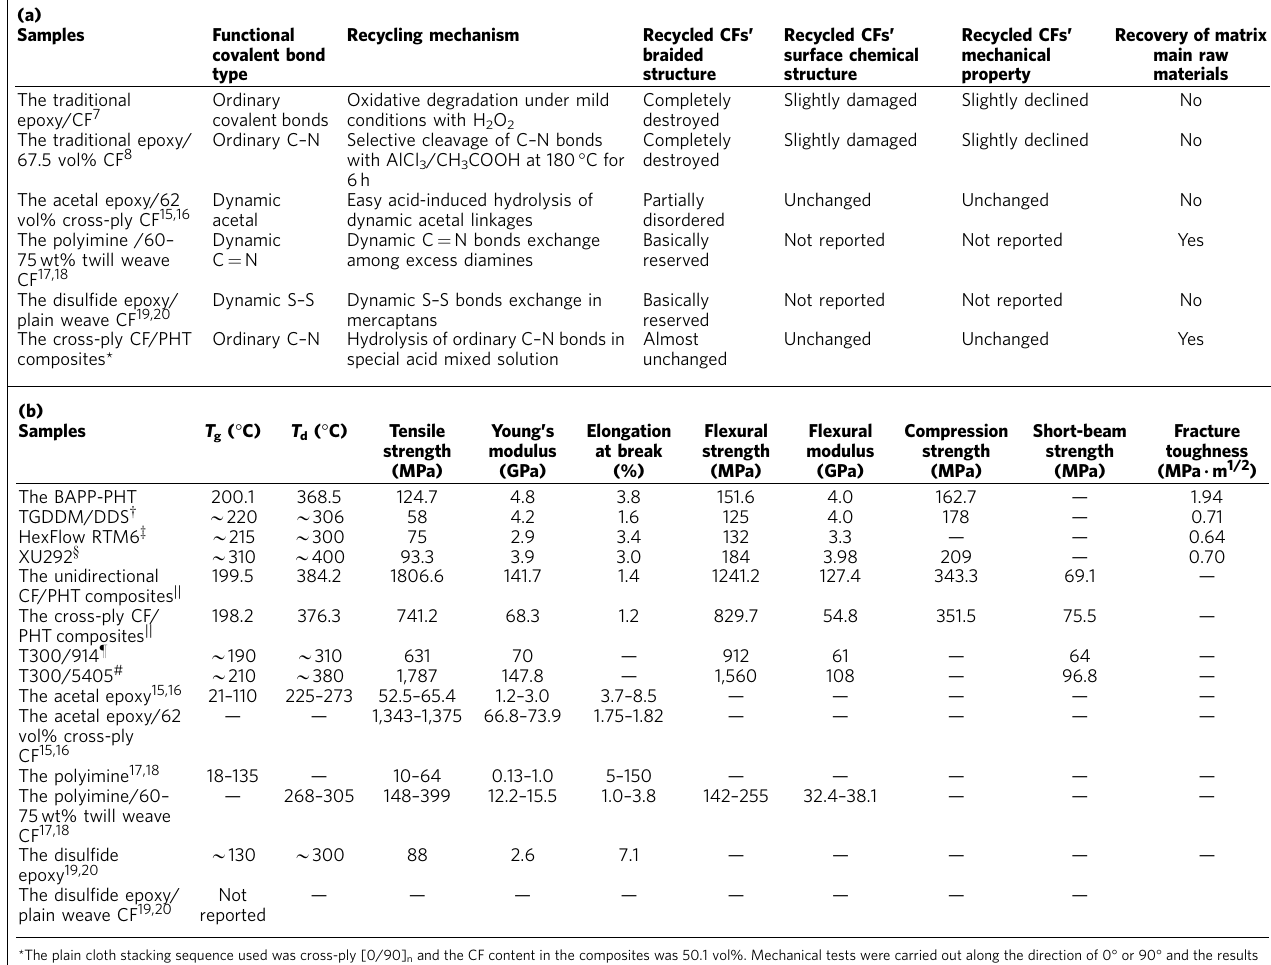
The acetal epoxy/62 vol% cross-ply CF 15,16